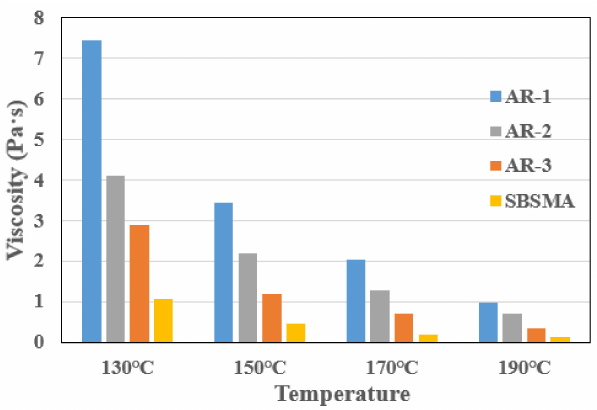
Figure 2. Results of Viscosity at 130 ◦ C, 150 ◦ C, 170 ◦ C and 190 ◦